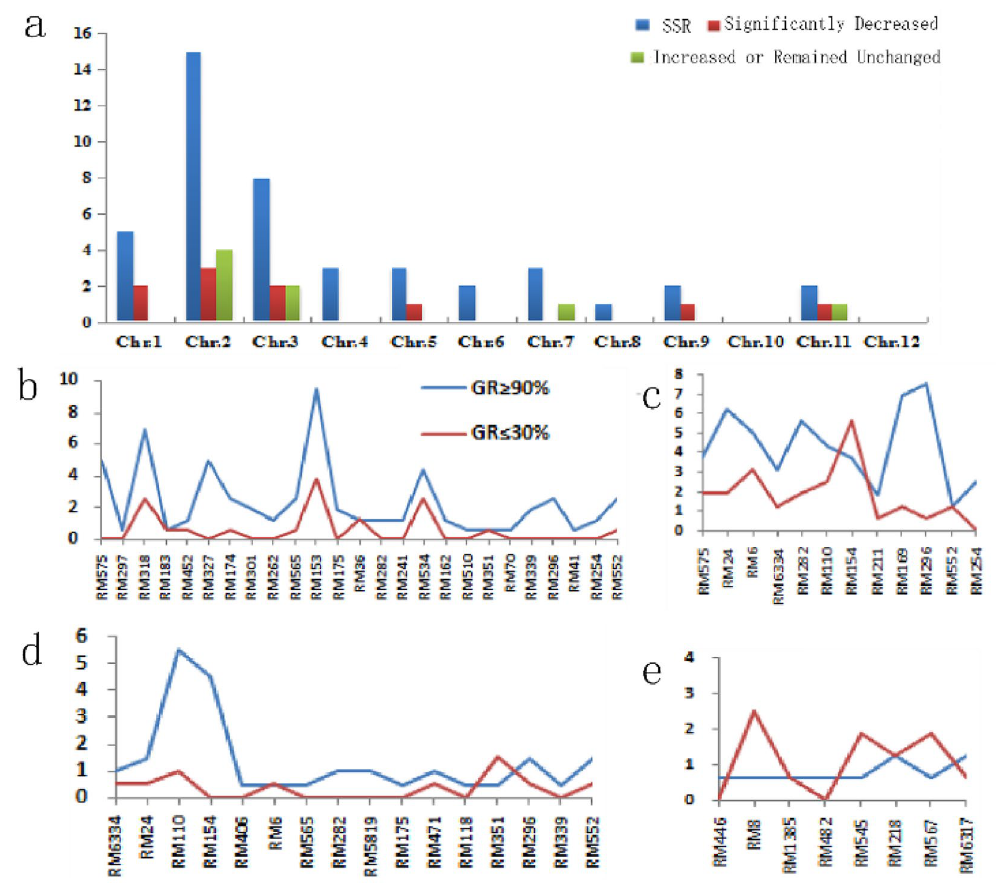
Figure 2. Distribution of SSR markers and variation of polymorphism frequency under different seed viability. ( a ) The distribution of SSR markers and the genetic integrity of different rice types. ( b , c , d , e ) The change of SSR markers in Dongxiang wild rice, Xianggu, 9194 and